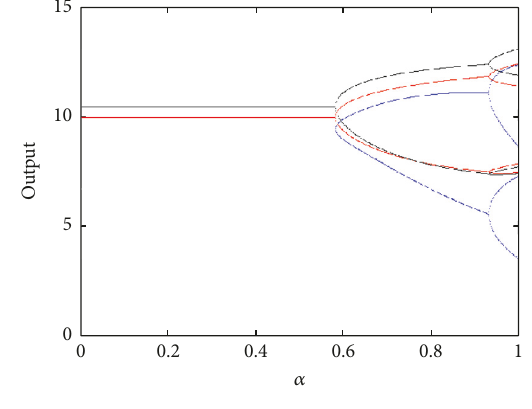
Figure 22: Bifurcation diagram with 𝛼 , 𝑘 = 2 .